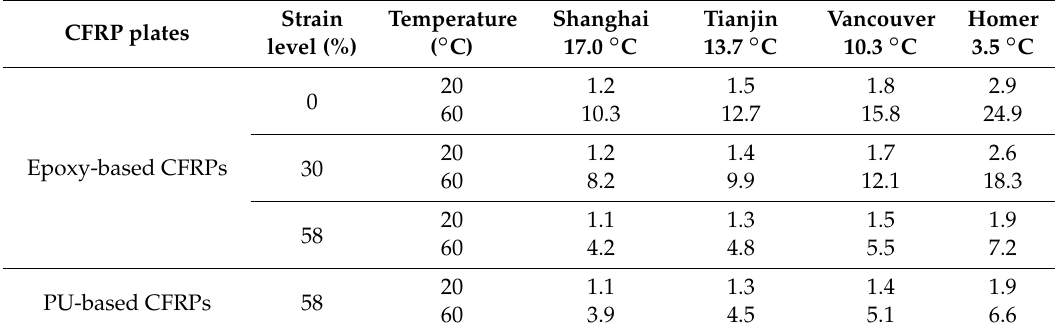
Table 6. Time-shift factors of both epoxy- and PU-based CFRPs immersed in seawater.